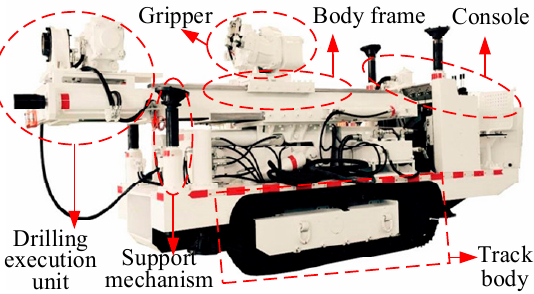
Figure 2. Crawler full hydraulic tunnel drilling rig for coal mines.